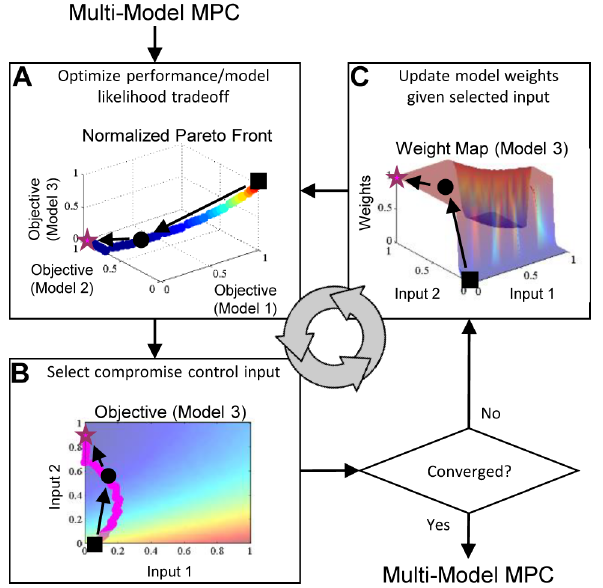
Figure 9. Illustration of control input selection with model weight adaptation. For a given prediction time interval in the control process, Pareto-optimal control inputs are computed by the multi- model MPC strategy by solving (7), which then enter an iterative process of control input selection and weight adaptation. ( A ) First, Pareto points are ranked with an initial weight vector v 0 and the optimal point (example: black square) is selected using (8). ( B ) Next, the input vector corresponding to the selected optimal point ( u 1 , black square) is identified. If the input vector continues to change above a pre-defined threshold, the process continues to the next iteration. ( C ) Given the current input vector ( u 1 ), a new weight vector ( v ( u 1 ), black square) is computed. The process continues and repeats (example: black circle, then magenta star) until the aforementioned stopping criterion is met. The final input vector ( u n , magenta star) is returned to the main control loop as the best compromise control strategy and used to update the prediction models in preparation for the next prediction time interval.